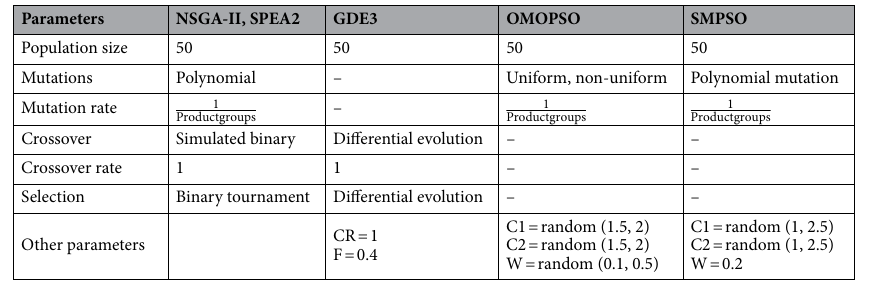
Table 5. Parameters setting for the